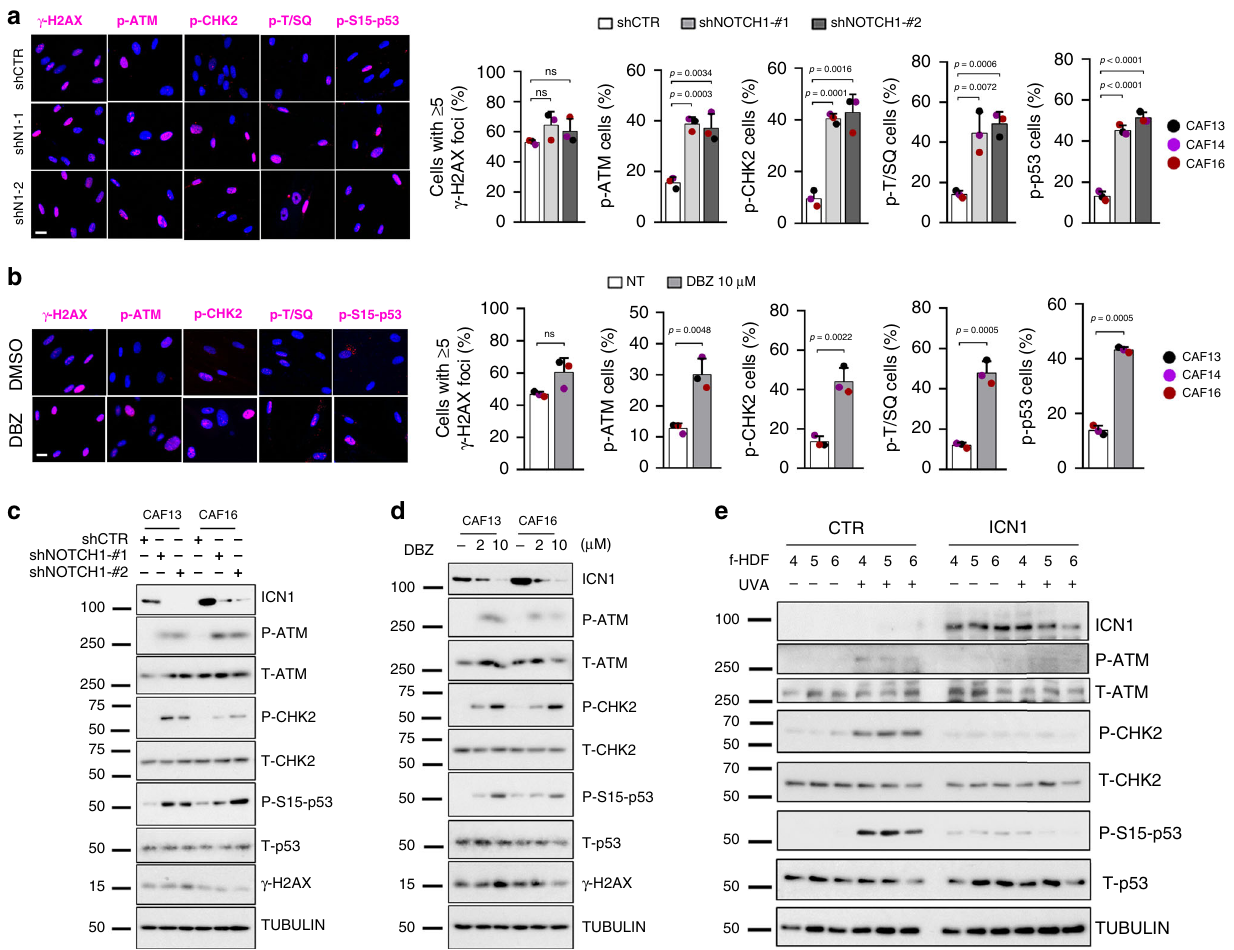
Fig. 6 Increased NOTCH1 expression in CAFs suppresses ATM/P53 signaling. a , b Representative images and quanti fi cation of immuno fl uorescence analysis with antibodies against the indicated proteins/epitopes of CAF strains plus/minus shRNA-mediated NOTCH1 silencing ( a ) or plus/minus DBZ treatment (10 μ M) for 5 days ( b ). Scale bar, 10 μ m. pS/TQ refers to the antibody-recognized phosphorylated SQ/TQ cluster domains that are structural hallmarks of various ATM and ATR substrates 40 . Values for each strain are indicated as dots with mean ± s.d. a n (cells)> 194 per sample. One-way ANOVA followed by Dunnett ’ s test; b n (cells) > 167 per sample. Two-tailed unpaired t -test. ** p < 0.01, *** p < 0.001, **** p < 0.0001. n (CAF strain) = 3. Immunoblot analysis of ICN1 expression levels is shown in Supplementary Fig. 4a, b. c , d Immunoblot analysis of two CAF strains plus/minus shRNA- mediated NOTCH1 silencing ( c ) or plus/minus DBZ treatment (2 and 10 μ M) for 5 days ( d ), with antibodies against P-ATM, P-CHK2, P-S15-p53, and respective total proteins, ICN1, γ -H2AX, and γ − TUBULIN (as equal loading control). The same blots were stripped and re-probed. e Immunoblot analysis of P-ATM, P-CHK2, P-S15-p53, and respective total proteins and γ -TUBULIN (as equal loading control) of f-HDF strains infected with an ICN1 expressing lentivirus versus empty vector for 5 days plus/minus UVA irradiation (500 mJ/cm 2 ) or mock treatment for the last 72 h. The same blots were stripped and re-probed. n (f-HDF strain) =